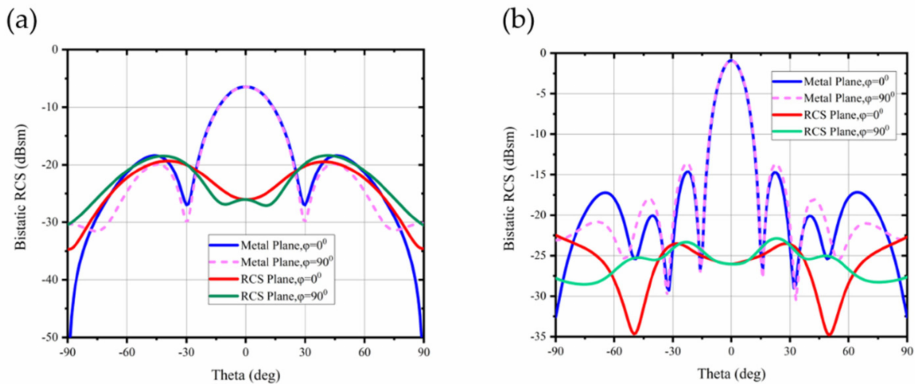
Figure 9. Bistatic RCS reduction: ( a ) f = 9.2 GHz and ( b ) f = 16.5